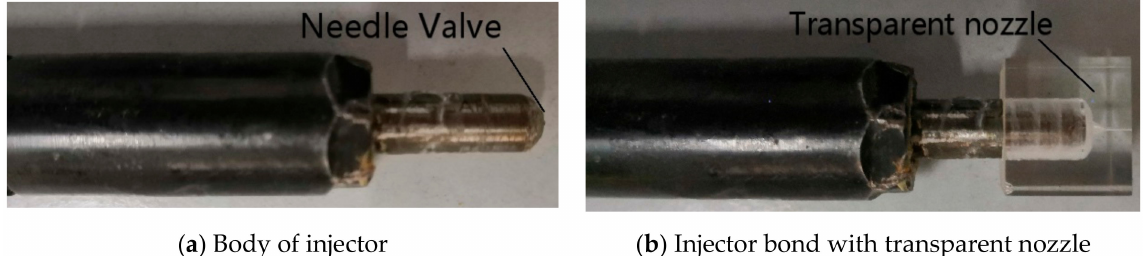
Figure 2. Experimental